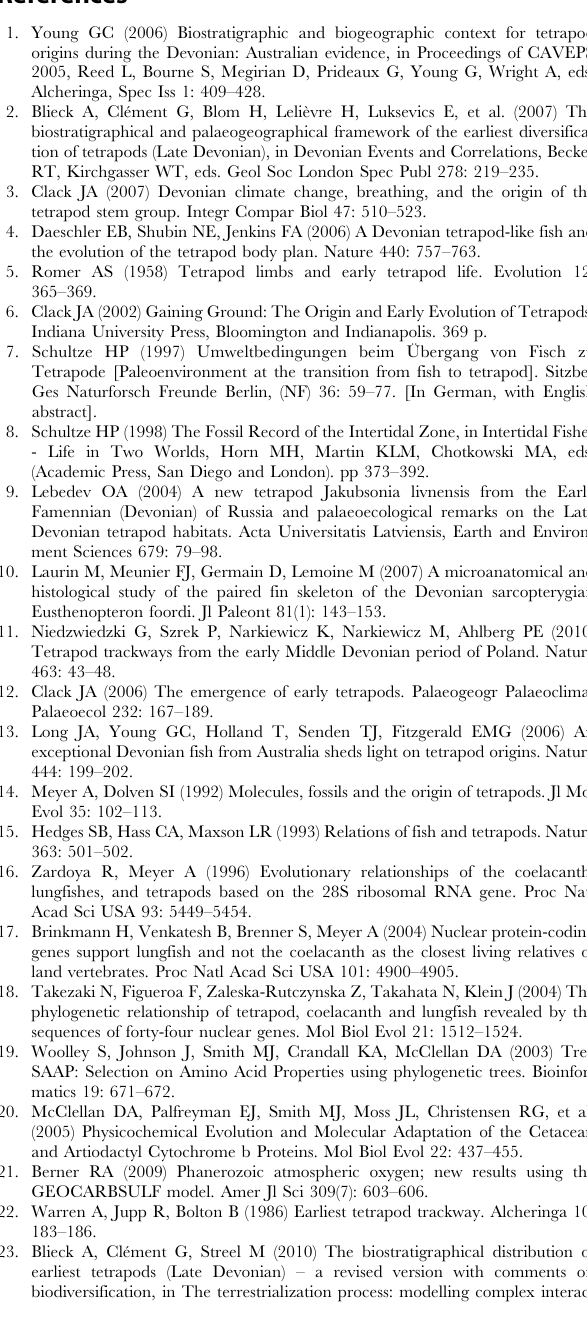
Table S2 Similar amino acid sites between the different groups of sarcopterygians which have been affected by positive-destabi- lizing during